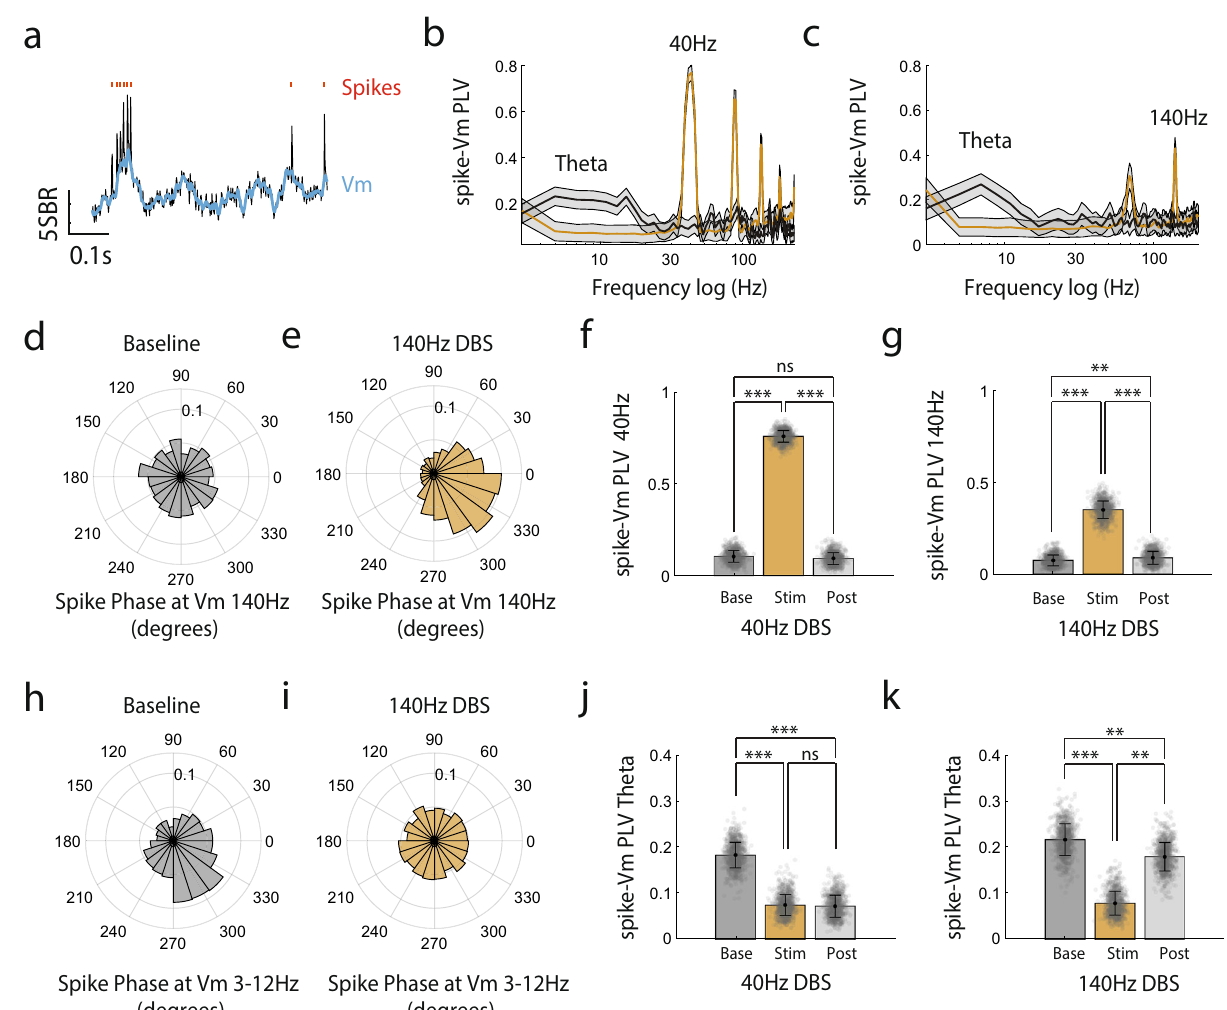
Fig. 4 | DBS entrains CA1 spiking at the stimulation frequency while reducing theta-rhythmicspikeoutput.a ExampleSomArchontrace(black)ofaCA1neuron with Vm highlighted blue (smoothed±6ms), and spike times marked with red ticks. b Population phase-locking value (PLV) of spikes to Vm across frequencies. Spikes from all neurons were concatenated for PLV computation (40Hz, n=1972, 140Hz, n =1867). Black line represents spike-Vm PLV during baseline period and golden line represents spike-Vm PLV during 40Hz DBS period. Shaded area is standard deviation estimated through bootstrapping. Frequency-axis is on a loga- rithmic scale. c Same as( b ),but for140HzDBS. d The population polarhistogram of spike times relative to the phase of Vm fi ltered at 140Hz using a Butterworth fi lter during the baseline period. e Same as ( d ), but during the 140Hz DBS period. f Quanti fi cation of spike-Vm PLV at the DBS 40Hz entrainment frequency during